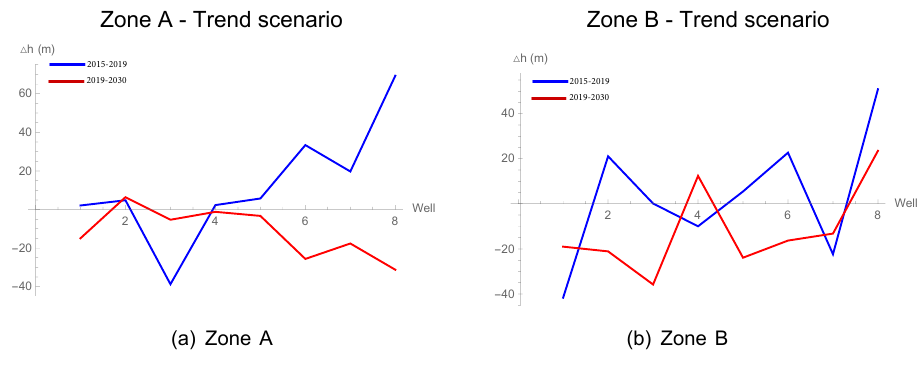
Figura 3.3: Variaci´on de la carga hidr´aulica en el escenario Tendencial de la Temporada Figure 17. Variation of the hydraulic head in the trend scenario of the dry season. de Secas.